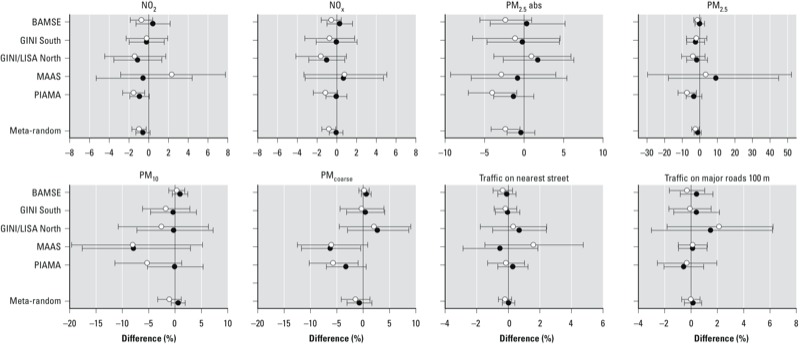
Adjusted center-specific and combined (meta-random) associations of annual average levels of air pollution and traffic indicators with FEV1. Error bars are 95% CIs. Associations with exposures at birth address are represented by black dots, and associations with exposures at current address by white dots. Estimates are adjusted for age, sex, height, weight, recent respiratory infections, ethnicity/nationality, parental education, allergic mother, allergic father, breastfeeding, mother smoking during pregnancy, smoking at home, mold/dampness at home, furry pets at home. Associations are presented for the following increments in exposure: 10 μg/m3 for NO2, 20 μg/m3 for NOx, 1 unit for PM2.5 absorbance (PM2.5abs), 5 μg/m3 for PM2.5, 10 μg/m3 for PM10, 5 μg/m3 for PMcoarse, 5,000 vehicles/day for traffic intensity on the nearest street; and 4,000 vehicle-km/day for traffic load on major roads within a 100-m buffer; associations with traffic intensity and traffic load were additionally adjusted for background NO2 concentrations.